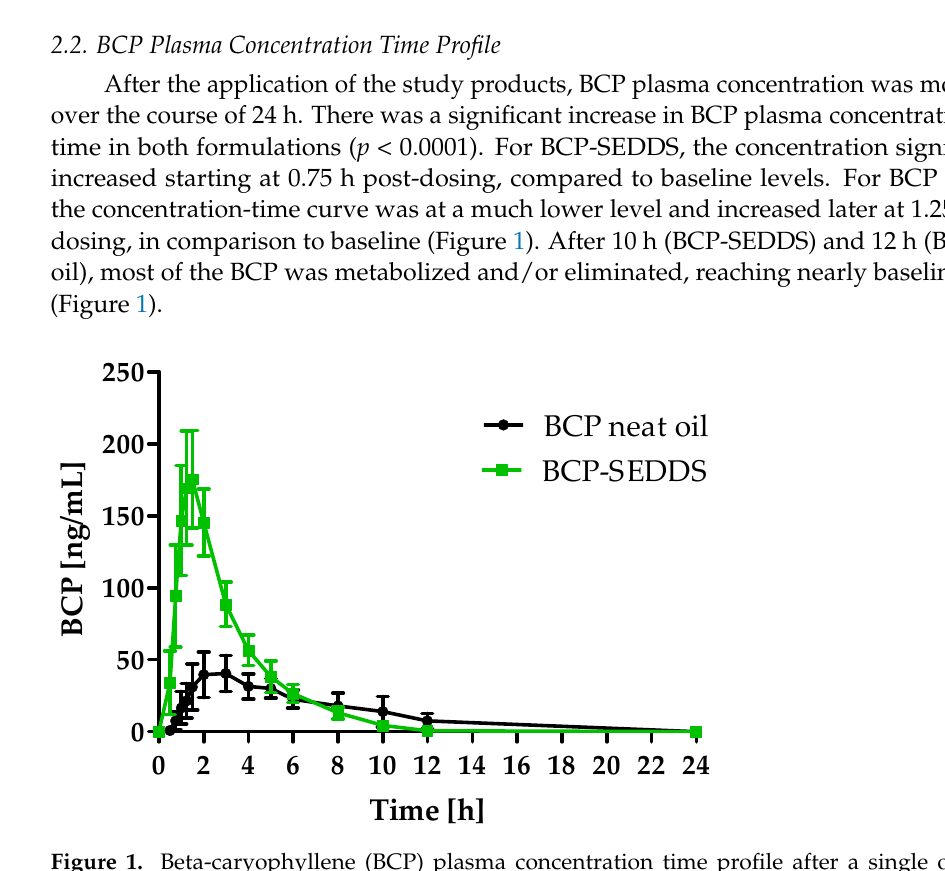
Figure 1. Beta-caryophyllene (BCP) plasma concentration time profile after a single oral dose of 100 mg BCP administered as self-emulsifying drug delivery system (BCP-SEDDS, green) and BCP neat oil (reference, black) depicted as summary curves of mean values at single time points (mean ± 95% CI) for all subjects. n = 24.